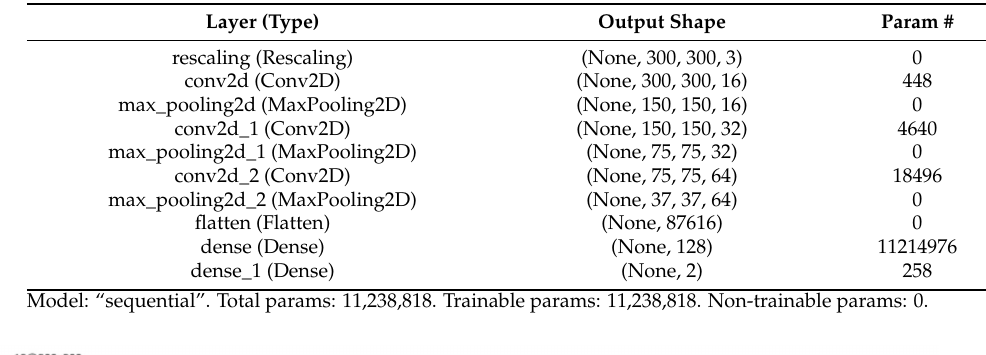
Table 3. Keras model summary.